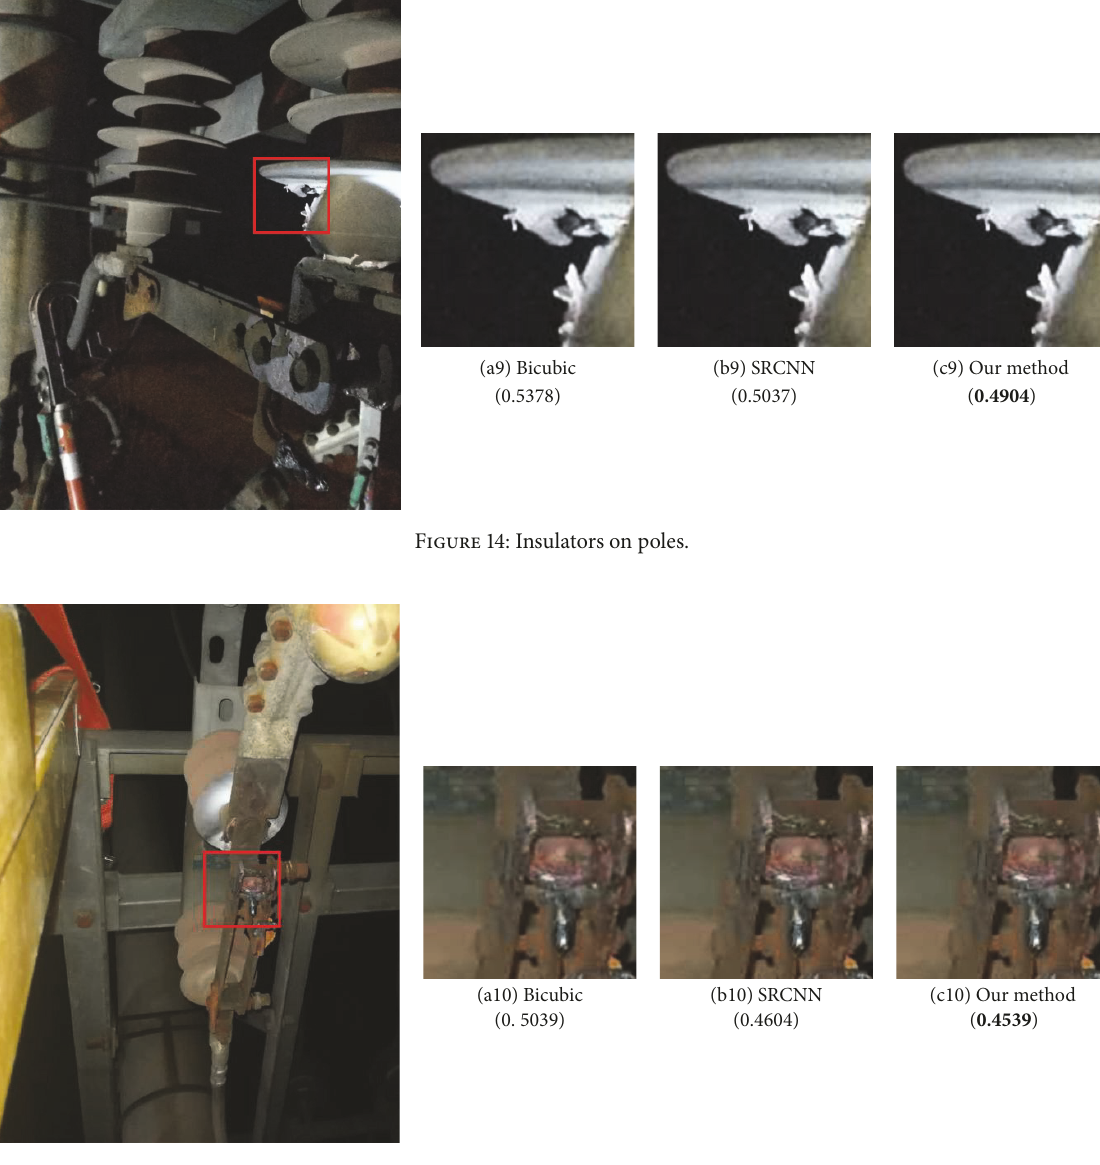
Figure 15: Switch